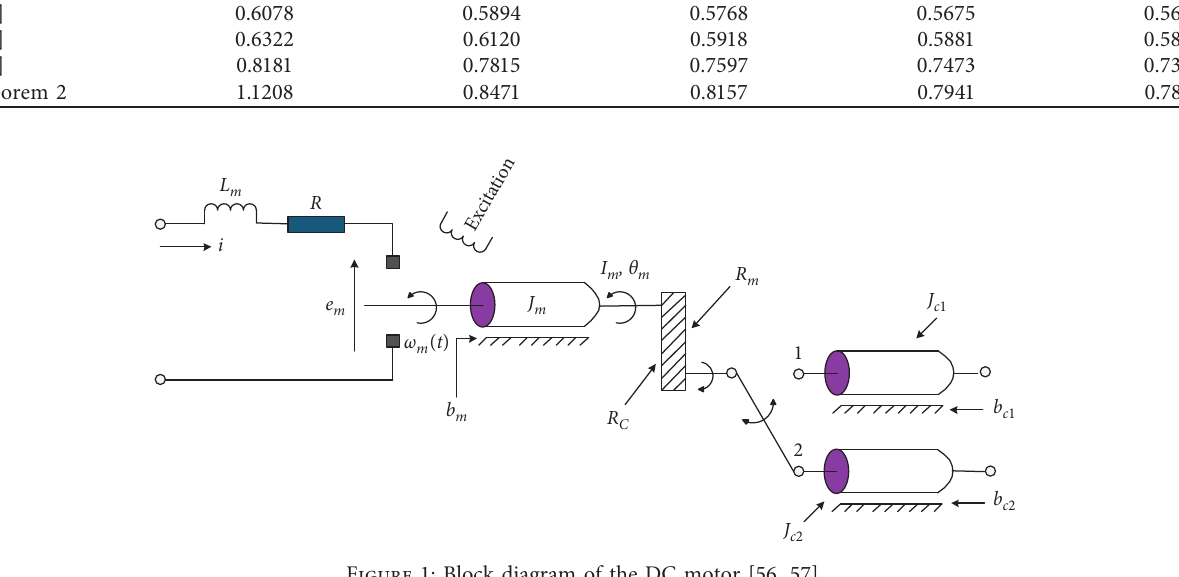
Figure 1: Block diagram of the DC motor [56,